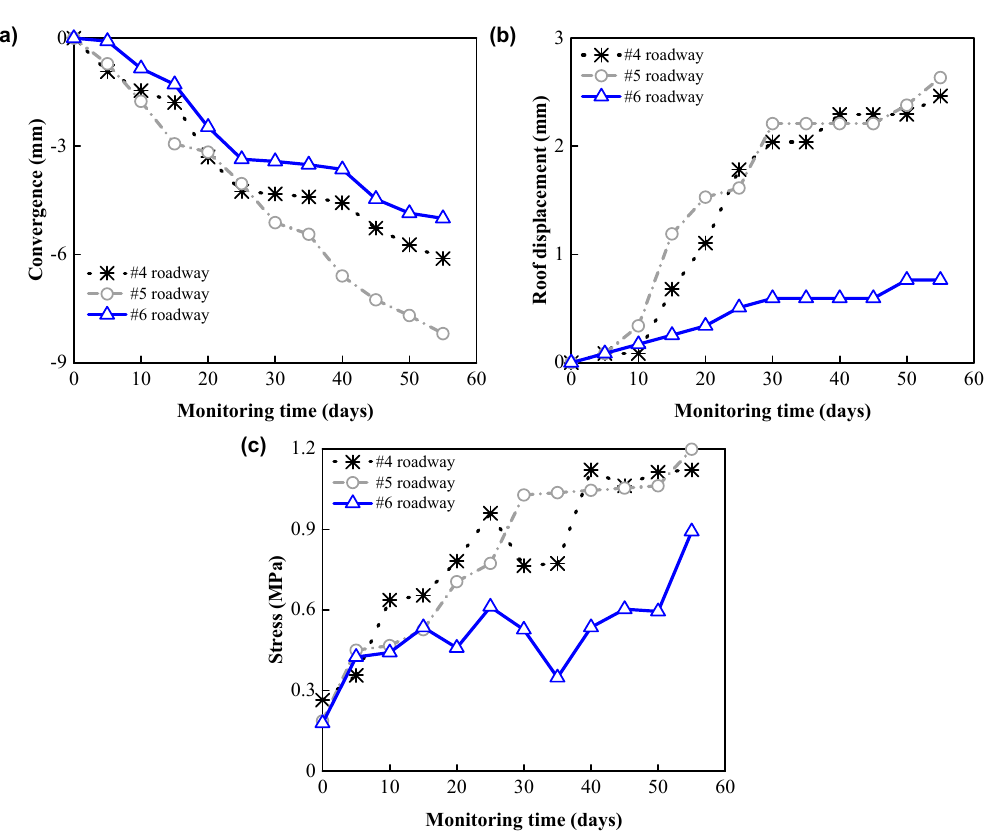
Figure 11. Variation of ( a ) convergence displacement, ( b ) roof displacement, and ( c ) stress with monitoring time.